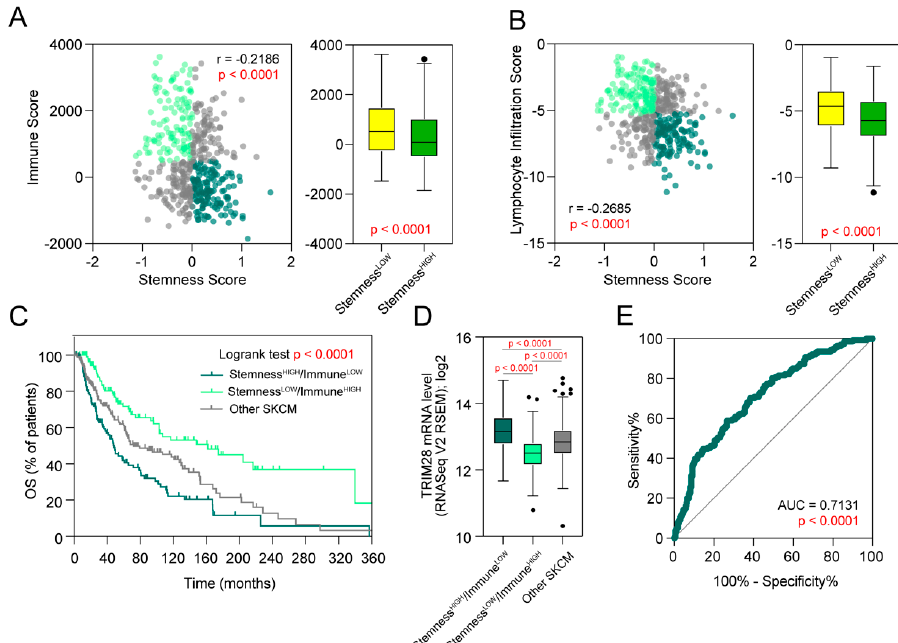
Figure 5. TRIM28 expression is strictly associated with stemness-high/immune-low melanoma phenotype and can predict the survival of melanoma patients. ( A ) Spearman correlation of the Stemness Score with the Immune Score in the SKCM TCGA data ( left panel ). Light green, dark green, and gray colors denote Stemness LOW /Immune HIGH , Stemness HIGH /Immune LOW , and other SKCM patients, respectively. Right panel presents Tukey box plots of Immune Scores in Stemness LOW and Stemness HIGH melanomas. ( B ) Spearman correlation of the Stemness Score with the Leukocyte Infiltration Score in the SKCM TCGA data ( left panel ). Right panel presents Tukey box plots of Lymphocyte Infiltration Scores in Stemness LOW and Stemness HIGH melanomas. ( C ) Kaplan–Meier overall survival curves for the SKCM TCGA cohorts separated into three subgroups based on Stemness Score and the Immune Score. Patients were divided into low or high subgroups based on the mean values for each score. ( D ) Tukey box plots of the expression of TRIM28 in three SKCM subgroups. The statistical significance is denoted in the graph (ANOVA followed by Tukey’s multiple comparisons test). ( E ) Diagnostic value of the TRIM28 expression in predicting the Stemness HIGH /Immune LOW classification of the SKCM TCGA patients. The area under the curve (AUC) was calculated for the ROC curve. 2.6. Significant Attenuation of the Interferon Signaling by TRIM28-Mediated Epigenetic Silencing of the IRF Transcription Factor Family Might Facilitate Stemness High/Immune Low Melanoma Phenotype Using the GSEA, we further searched for target genes of known transcription factors (TFs) in the list of all differentially expressed genes in TRIM28 HIGH phenotype. As TRIM28 is a transcriptional co-